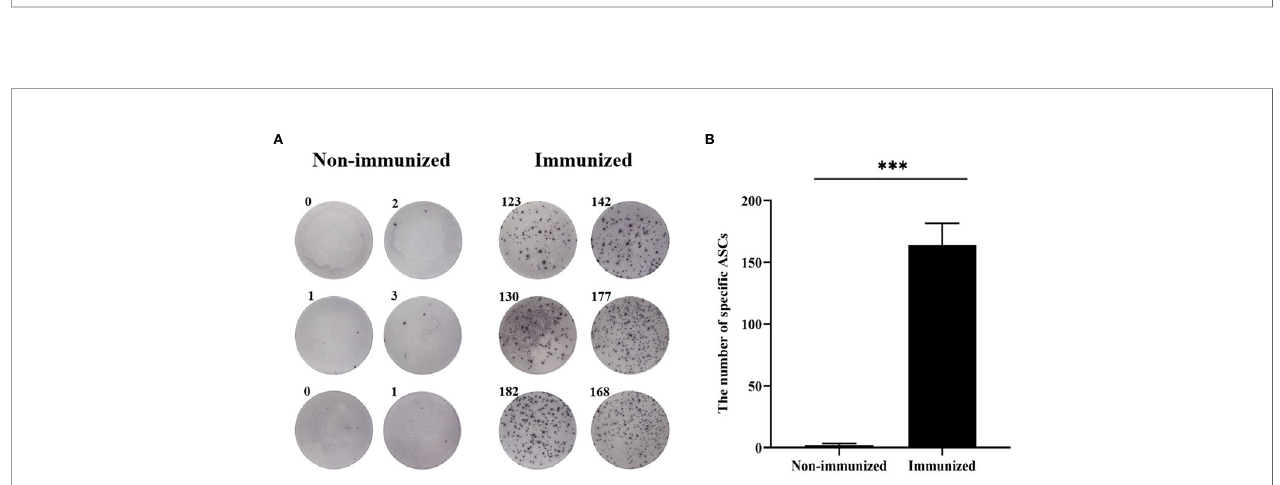
FIGURE 9 | The speci fi c B-cell response was tested by ELISPOT. (A) The representative ELISPOT plot of speci fi c B-cell response. (B) There were hardly any speci fi c B-cell spots in the Non-immunized group, and the number of ASCs in immunized group was signi fi cantly higher than that in Non-immunized group. (***P <